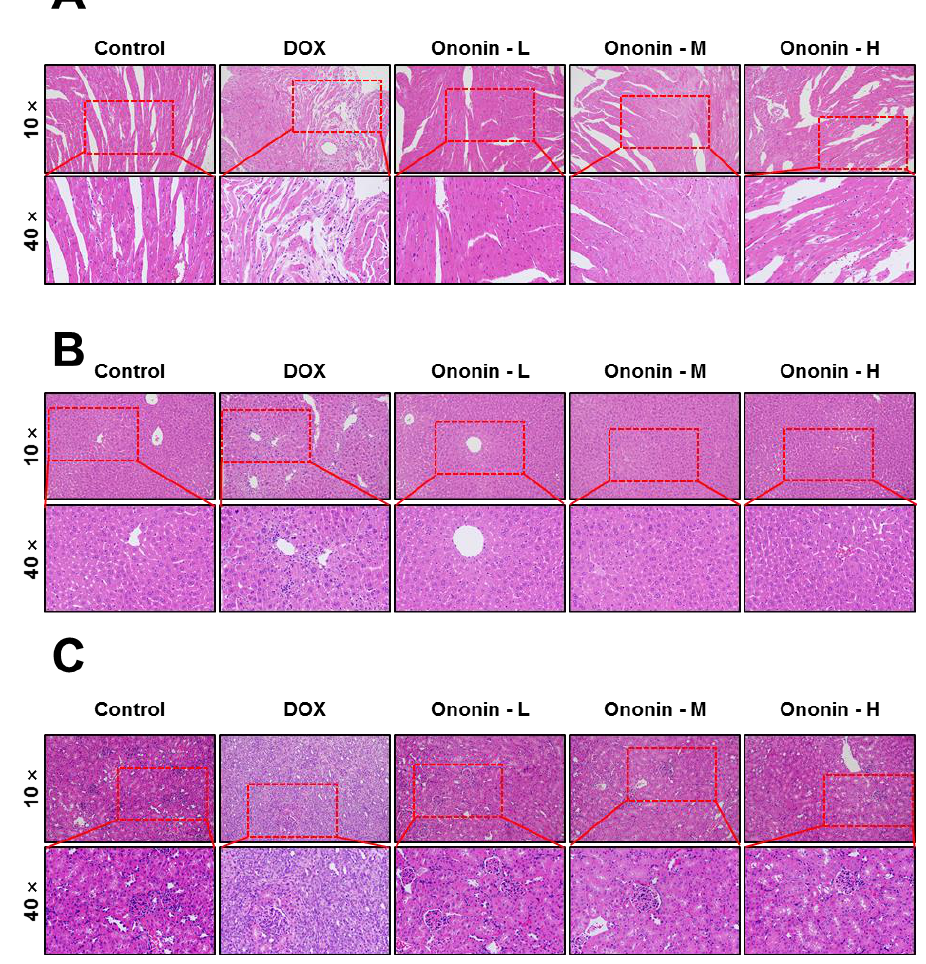
Figure 10. Biosafety of ononin in vivo . HE staining of ( A ) heart, ( B ) liver, and ( C ) kidney in MG-63 xenograft mice obtained from different groups. Ononin at 1, 3, and 10 mg/kg/i.p were shown as -L, -M, and -H, respectively.